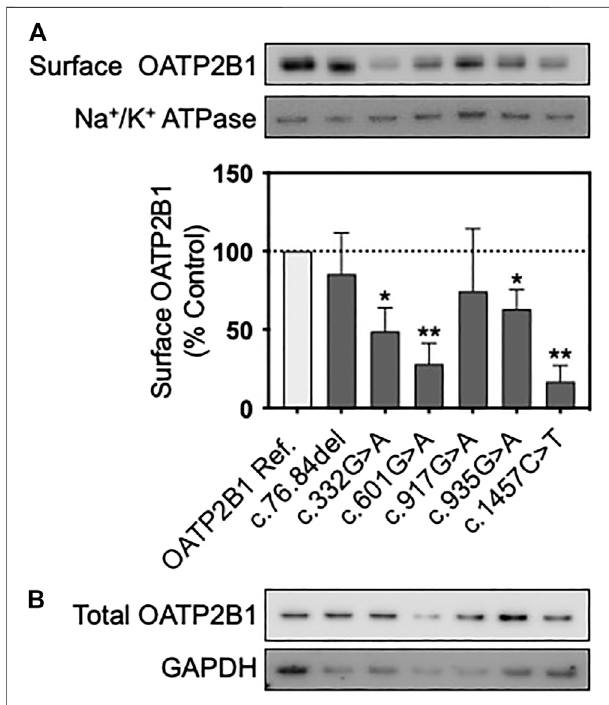
FIGURE 3 | Protein expression of OATP2B1 genetic variants. Representativewesternblotsof (A) cellsurfaceand (B) totalOATP2B1protein expression in HEK293T cells transfected with OATP2B1 reference and OATP2B1 genetic variants. Western blot analysis of surface OATP2B1 protein expression was normalized to Na + /K + ATPase. Results are shown as mean ± SEM ( n (cid:2) 3), * p < 0.05, ** p < 0.01.